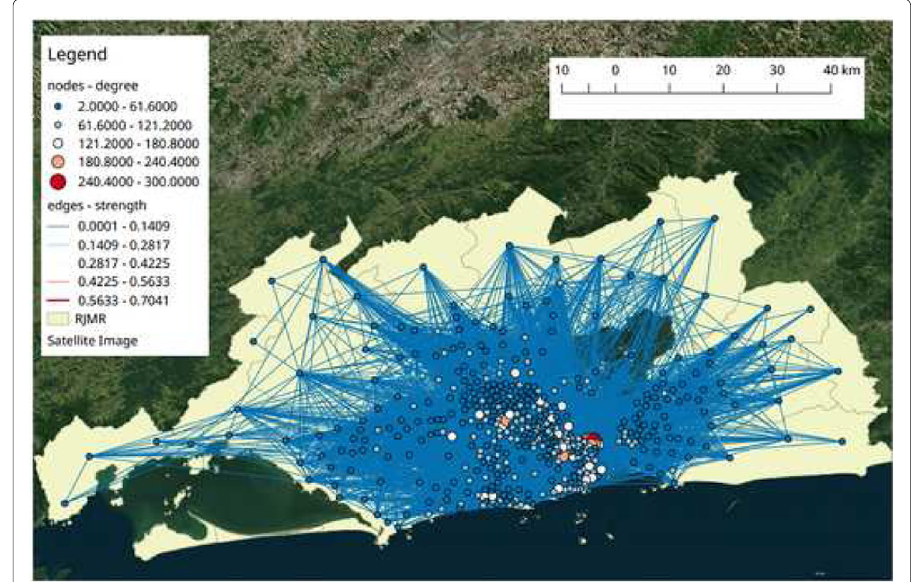
Fig. 6 Urban mobility geographical graph, (geo)graph, for the Metropolitan Region of Rio de Janeiro (highlighted area). Each node represents a traffic zone, and each edge corresponds to a flow intensity equal to or greater than the connection threshold (4.7E-5). The element’s colors and size are proportional to the topological degree (for the nodes) and topological strength (for the